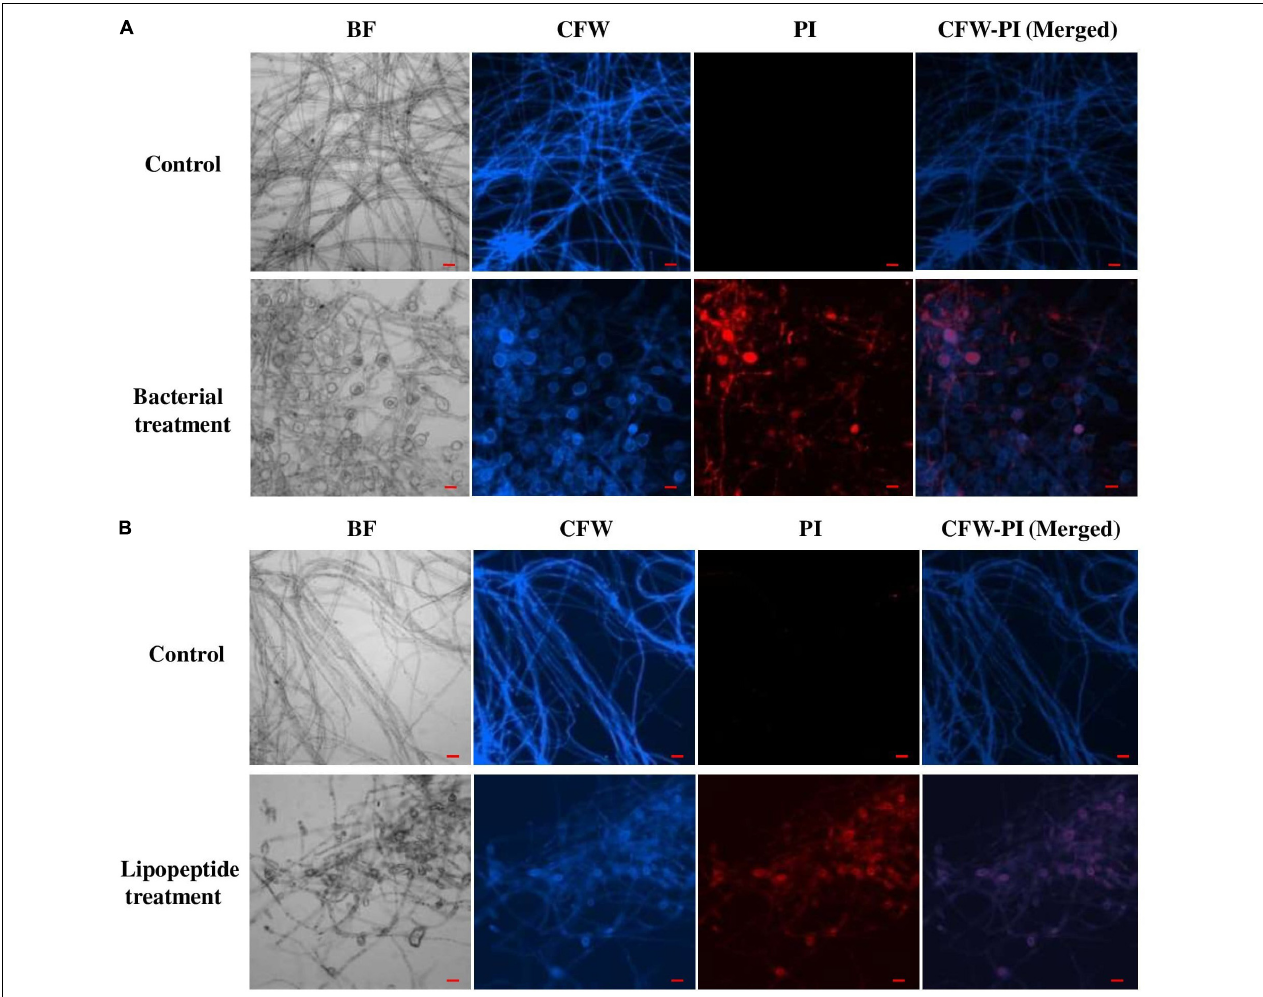
FIGURE 6 | Effect of bacterial ( Bacillus subtilis ) (A) and lipopeptides (B) on Fusarium hyphae was observed under bright field and fluorescent microscopy (CFW and PI). Bacterial treatment was done by co-cultivation of Fusarium with Bacillus subtilis in mixed media of nutrient and potato dextrose agar. Lipopeptide treatment was done by disc diffusion (each disc contain 20 µ l of 10 µ g µ l - 1 methanolic solution of lipopeptide), hyphae growing near the disc was taken for microscopy. In control-A fungus was not challenged with bacteria and control B- disc was only loaded with 20 µ l of methanol without lipopeptide (Scale bar = 20 µ